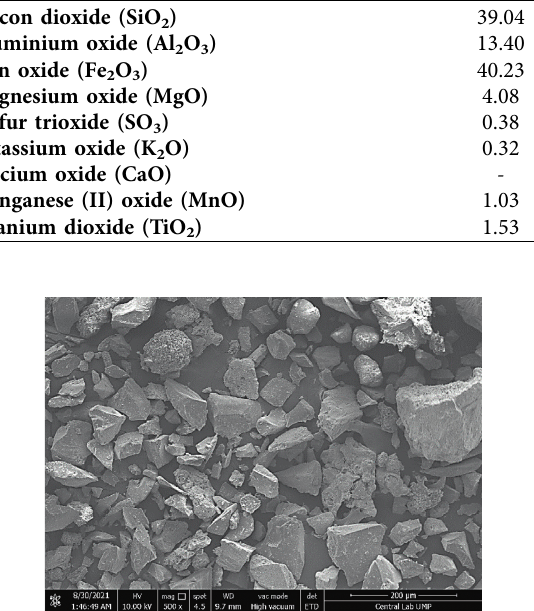
Figure 3: SEM spent garnet.